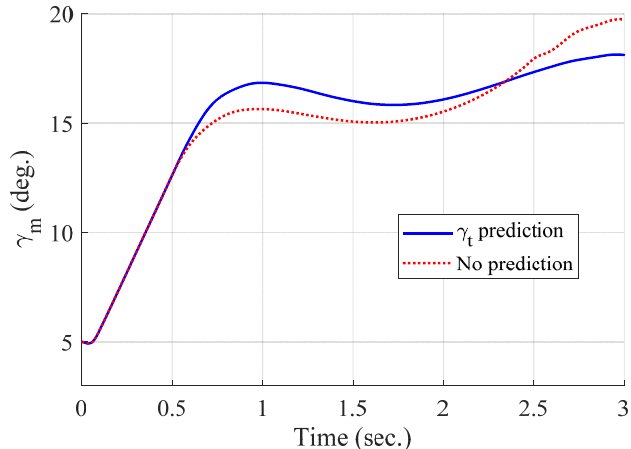
Figure 9. Flight-path angle of the missile (single run-simulation).